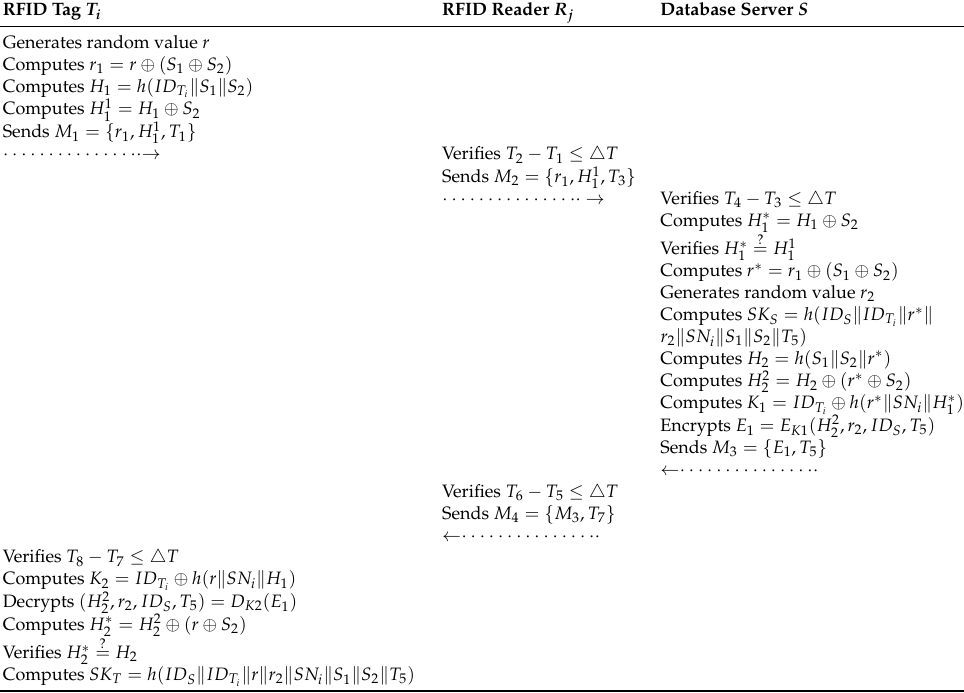
Table 5. Login and authentication phase of